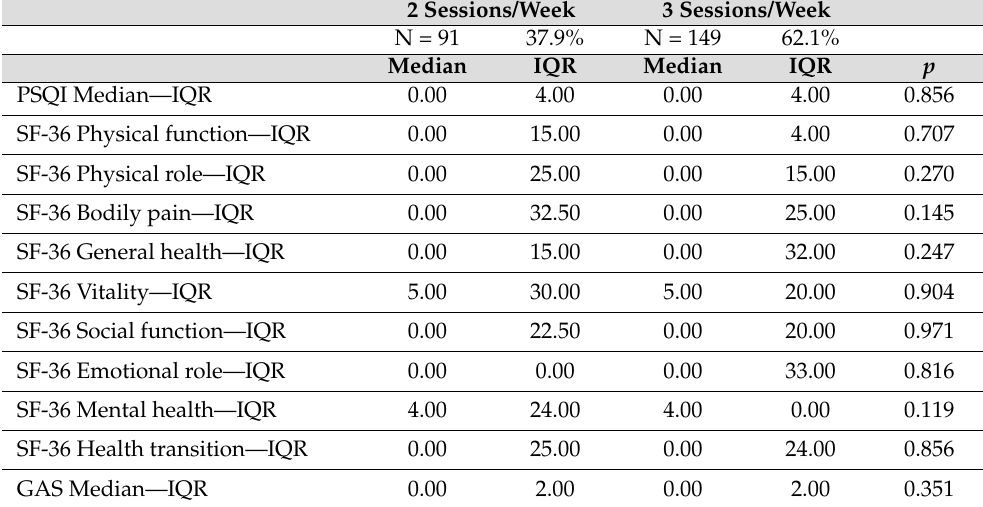
Table A2. Comparison of differences between baseline and final values based on weekly treatment